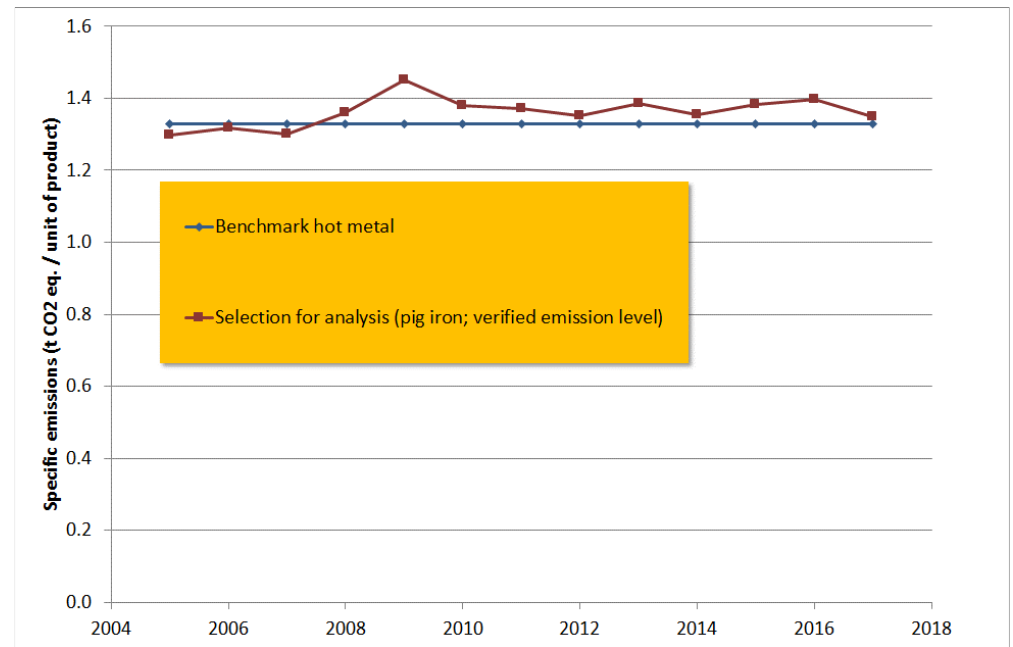
Figure 8. Specific emissions of pig iron compared to the benchmark for molten metal (straight line). Source: World Steel Association [27]; Benchmark for molten metal [3]; own calculation [19].